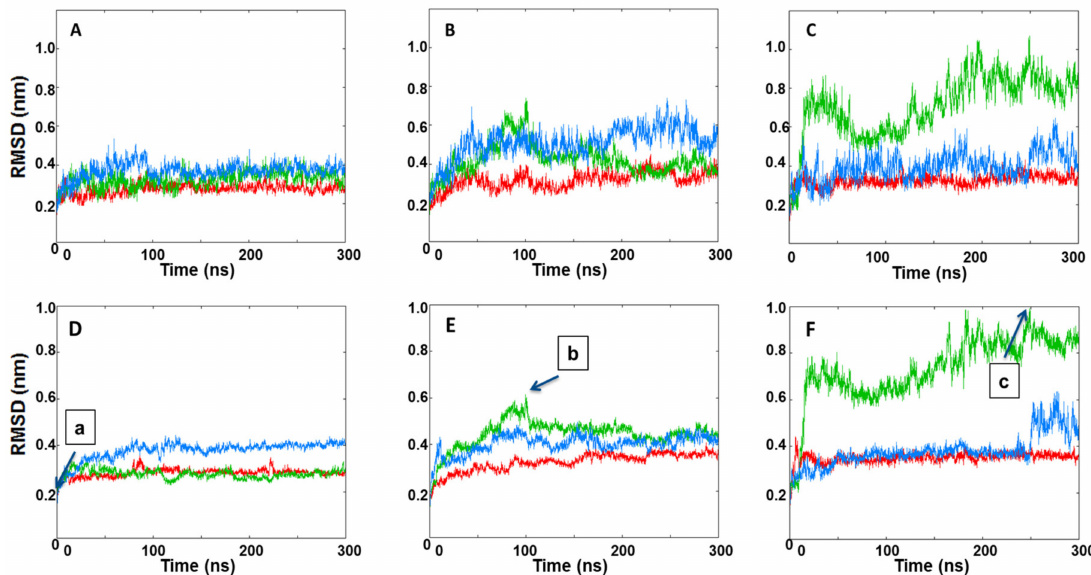
Figure 5. The RMSDs of IRE1 face-to-face dimer C α atoms during the three MD simulation replicas of ( A ) a native face-to-face crystal dimer structure (PDB code: 3P23), ( B ) KIRA docked in PDB 3P23 dimer, ( C ) protein–protein docked pose of PDB 4U6R in the face-to-face dimer form. Interface RMSDs of IRE1 face-to-face dimer C α atoms during the three MD simulation replicas of ( D ) a native face-to-face crystal dimer structure (PDB code: 3P23), ( E ) KIRA docked in PDB 3P23 dimer, ( F ) protein–protein